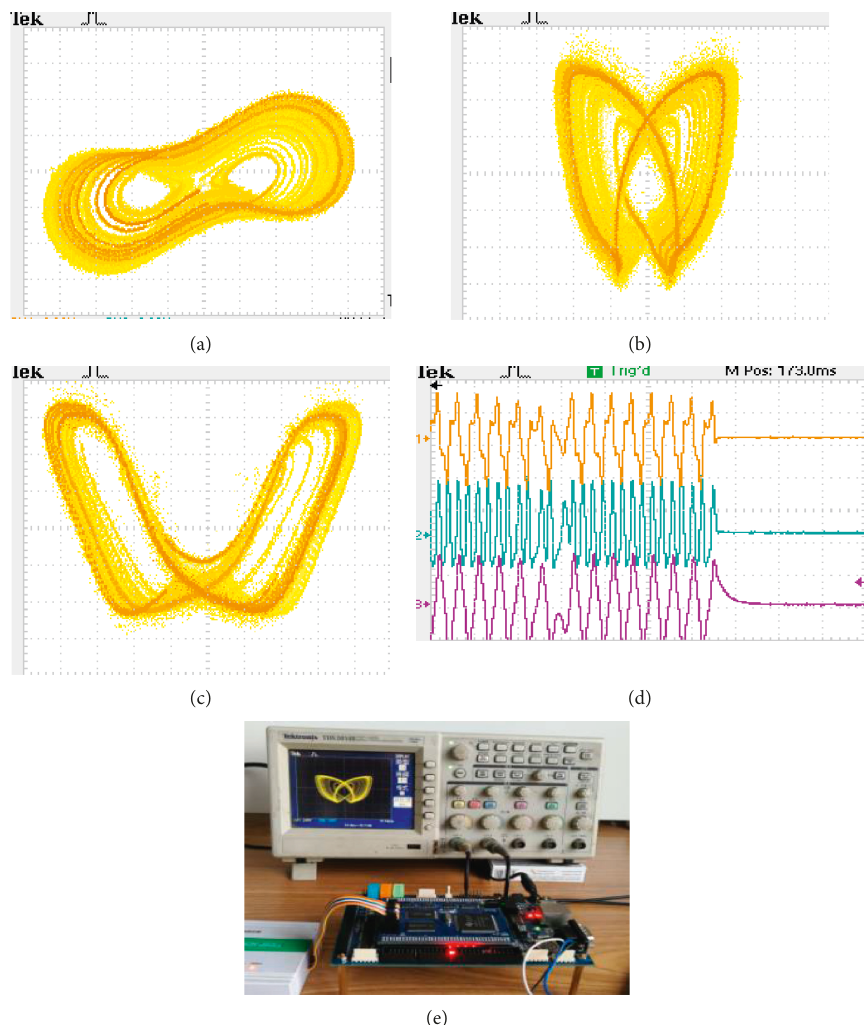
Figure 10: DSP-based realization for (a)–(c) chaotic attractors; (d) stabilization process; (e) experiment